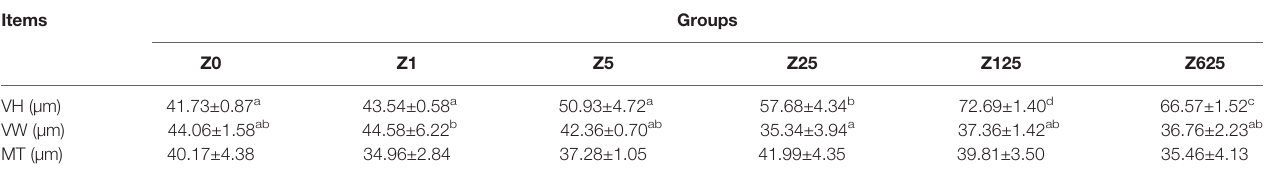
TABLE 4 | Intestinal structure of L. vannamei fed the experimental diets. Items Groups